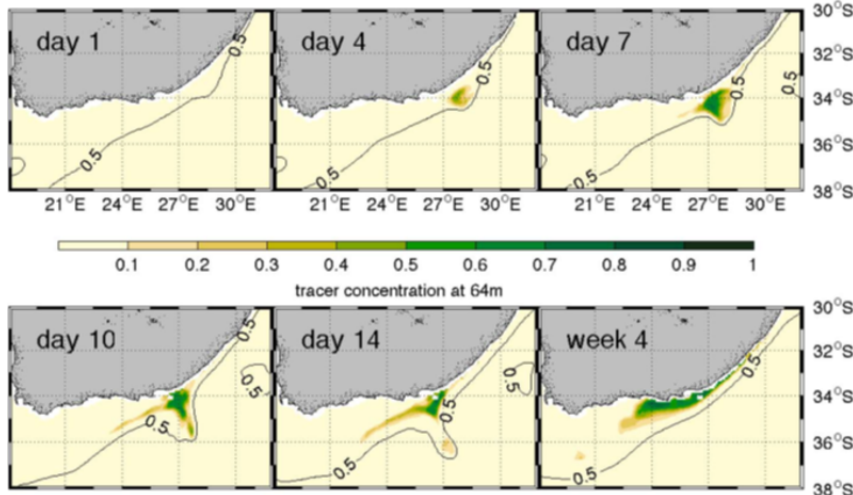
Figure 6. Tracer concentration at 64m in AGU-HYCOM to reveal shelf-edge upwelling. Tracers were initialized in the Agulhas Current below 400m over a 6-week period during a meander event in 2001 and used as a proxy for upwelling. The 0.5m sea level contour is highlighted to show the inshore edge of the current as the meander propagates along the coast (after Malan et al., 2018).